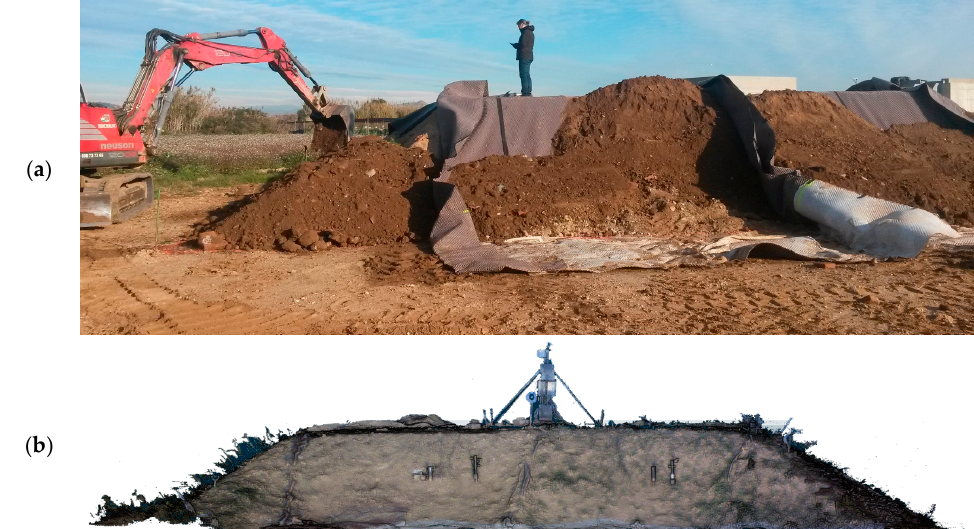
Figure 1. ( a ) Photograph of the embankment during the construction ; ( b ) 3D view of the point cloud obtained by terrestrial laser scanning.